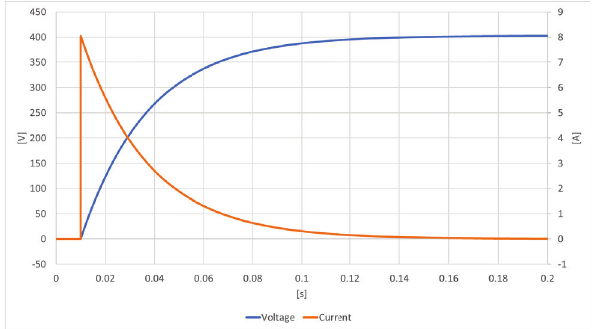
Fig. 2. Simulated pre-charge waveforms.